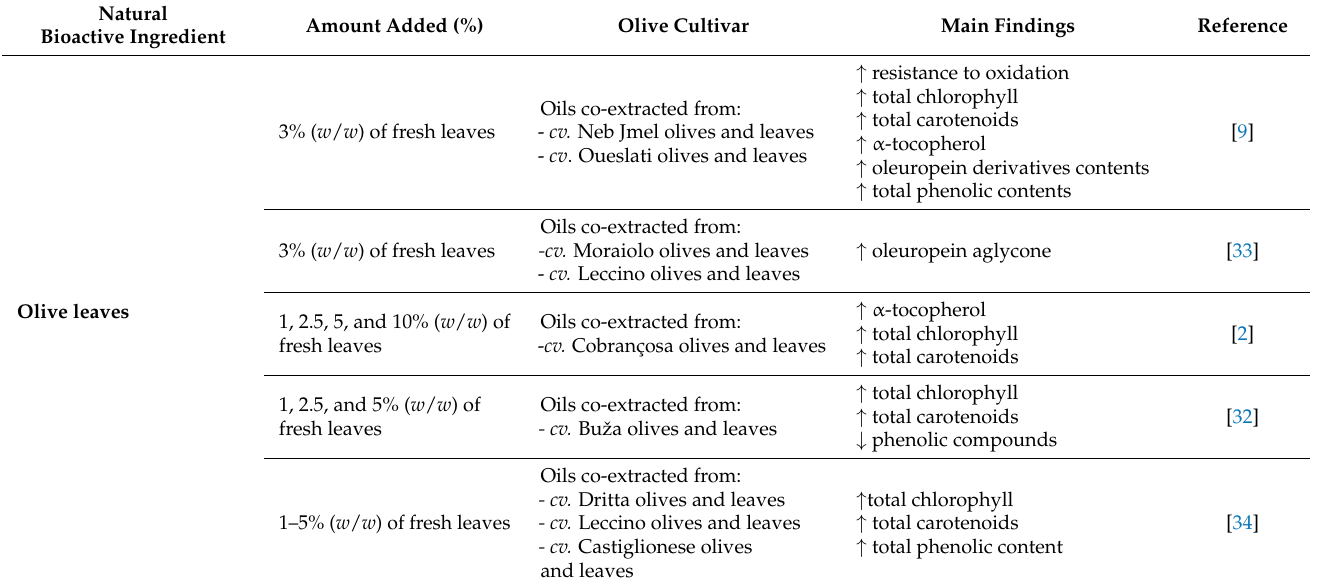
Table 1. Literature summary of the studies reporting olive oil co-extraction with natural bioactive ingredients and its effects on oils health-related